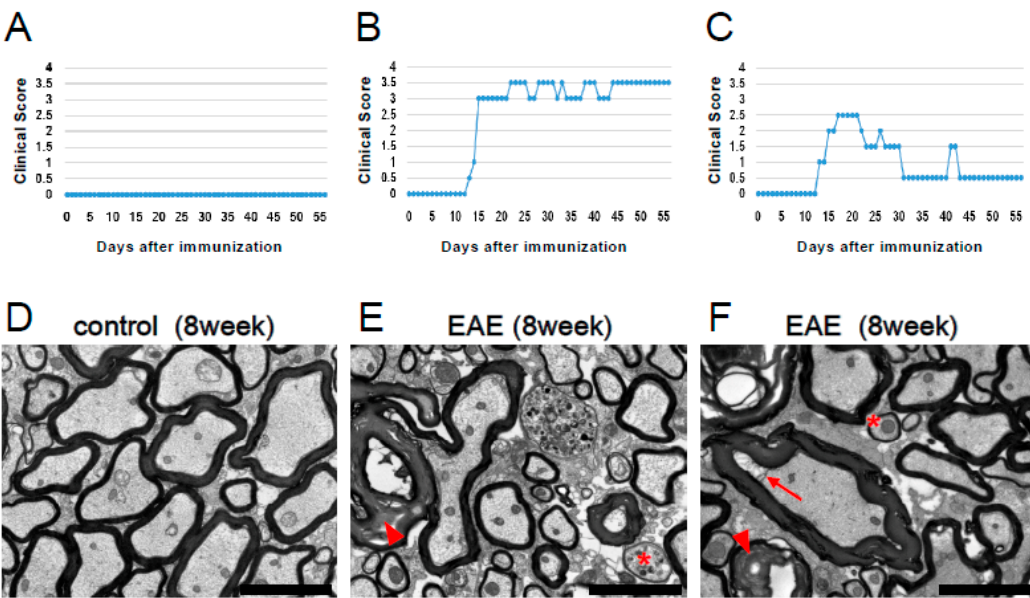
Figure 4. Clinical scores ( A – C ) and EM findings ( D – F ) in control ( A , D ) and MOG-injected EAE mice ( B , C , E , and F ) that either retained high clinical scores ( B , E ) or showed an improvement in clinical scores ( C , F ). Axons and myelin were intact in the lumbar spinal cord of control mice ( D ). In contrast, both demyelination (excess formation of myelin [arrowheads in E and F ], detachment of myelin from axon [arrow in F ]) and remyelination (asterisks in E and F ) were observed in lumbar spinal cords after EAE induction. Scale bars = 3 µ m ( D – F ). Abbreviations: EM, electron microscopy; MOG, myelin oligodendrocyte glycoprotein; EAE, experimental autoimmune encephalomyelitis.